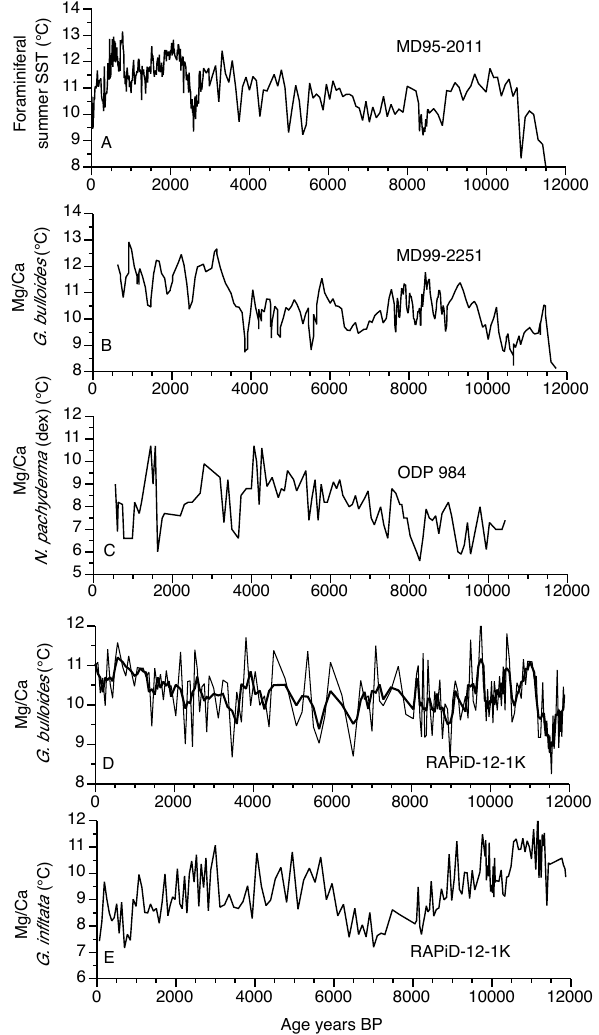
Fig. 8. Foraminiferal-based temperature records from the eastern Norwegian Sea and the northern North Atlantic south of Iceland. (A) Sea-surface temperature estimates for summer (JAS) for site MD95-2011 (Andersson et al., 2003; Risebrobakken et al., 2003; this study). (B) Mg/Ca sea-surface temperatures for MD99-2251 based on G. bulloides (Farmer et al., 2008). (C) Mg/Ca sea-surface temperatures for ODP 984 based on N. pachyderma (dex) (Came et al., 2007). (D) Mg/Ca sea-surface temperatures for RAPiD-12-1K based on G. bulloides (Thornalley et al., 2008). (E) Mg/Ca sea- surface temperatures for RAPiD-12-1K based on G. inflata (Thor- nalley et al.,